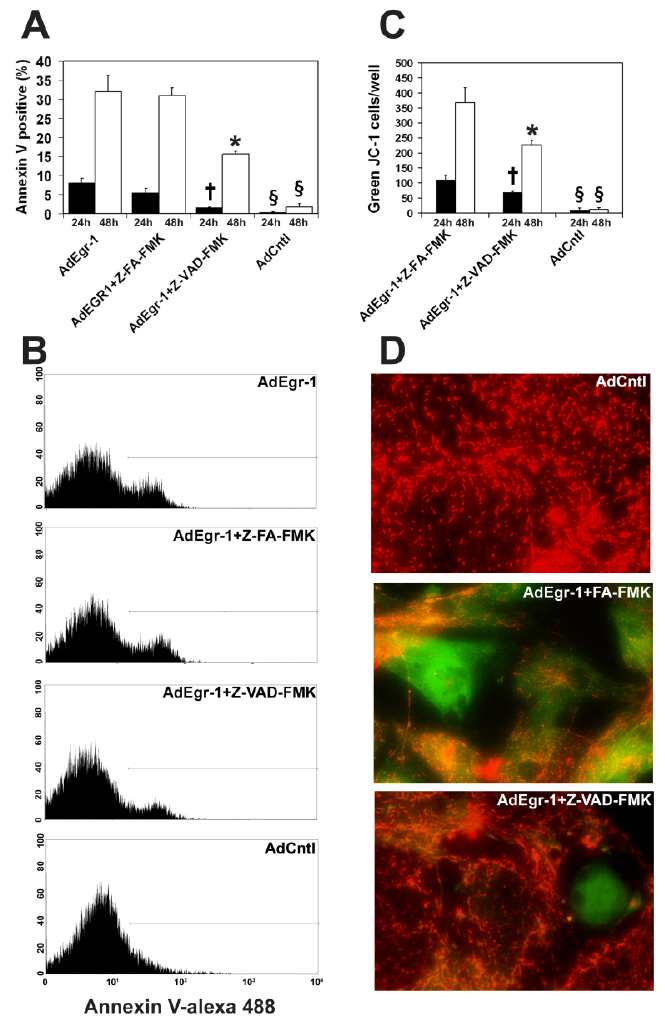
Figure 2. Apoptosis induced by Egr-1 in cardiac fibroblasts is caspase dependent. ( A ) AdEgr-1 induction of apoptosis 24 and 48 h post-infection assessed by binding of alexa 488 conjugated annexin V in FACS analyses is inhibited by the pan-caspase inhibitor Z-VAD-FMK when compared to the negative Z-FA-FMK control or AdEgr-1 cultures ( † p < 0.005, * p < 0.0005). Empty adenovirus (AdCntl) cultures were significantly different from all AdEgr-1 cultures (§ p < 0.001). Experiments incorporate the standard deviation of three experiments; ( B ) Representative FACS histograms 24 h post-infection; ( C ) Staining with JC-1 shows AdEgr-1 induces mitochondrial membrane depolarization that is partially inhibited by addition of Z-VAD-FMK when compared to the negative Z-FA-FMK control ( † p < 0.005, * p < 0.0005). Empty adenovirus (AdCntl) cultures were significantly different from all AdEgr-1 cultures (§ p < 0.001); and ( D ) Representative diagrams showing JC-1 staining (magnification